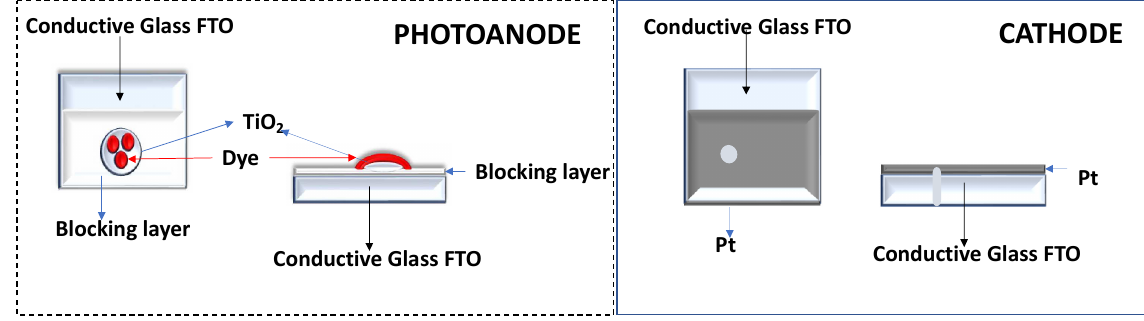
Figure 3. Representative schemes of the photoanode and cathode. The dye was adsorbed to the TiO 2 film by soaking in a 0.5 mM dye solution for the required time, Figure 4.